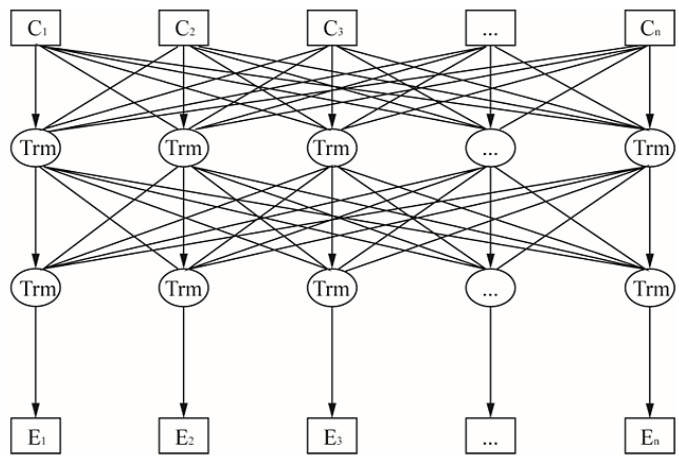
Figure 4. Basic structure of the ALBERT model.